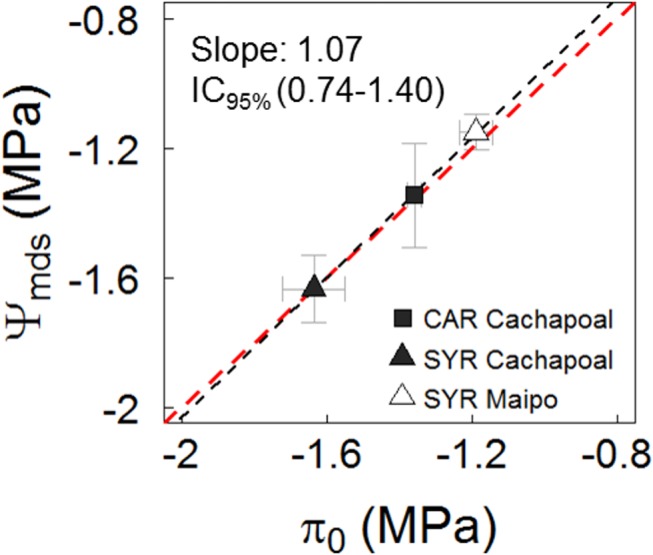
Relationship between mean midday water potential (Ψmds) observed in leaves at values gs < 0.05 mmol m-2 s-1 and the osmotic potential at full turgor (π0) in predrought leaves. Black and red line are fit and 1:1 relationship. The slope and confidence interval at 95% are presented.